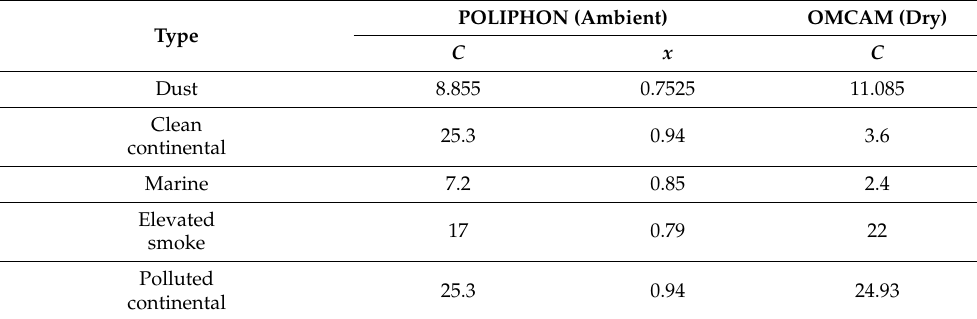
Table 2. Conversion factor ( C in Mm cm − 3 ) and extinction exponent ( x ) values for POLIPHON and OMCAM algorithms used to estimate n j ,dry from Equation (1). Note that x = 1 for